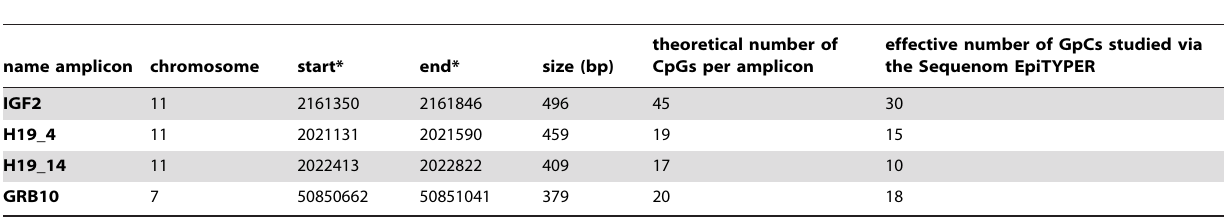
Table 4. Chromosomal location of the IGF2 , H19 and GRB10 amplicons used in the Sequenom